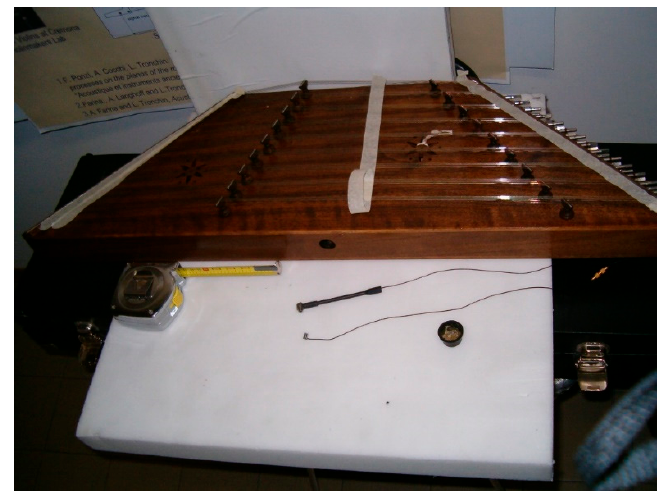
Figure 3. The Persian santoor analyzed in this research.